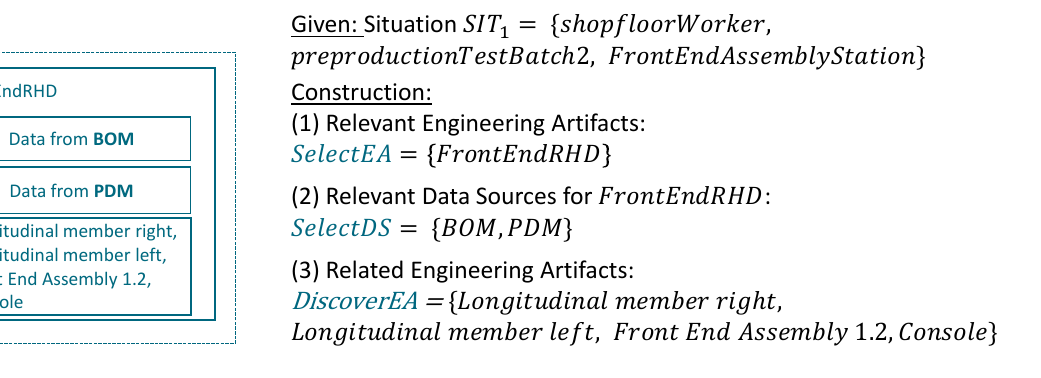
Figure 5. Construction of a DIP using the operators with respect to the use case scenario